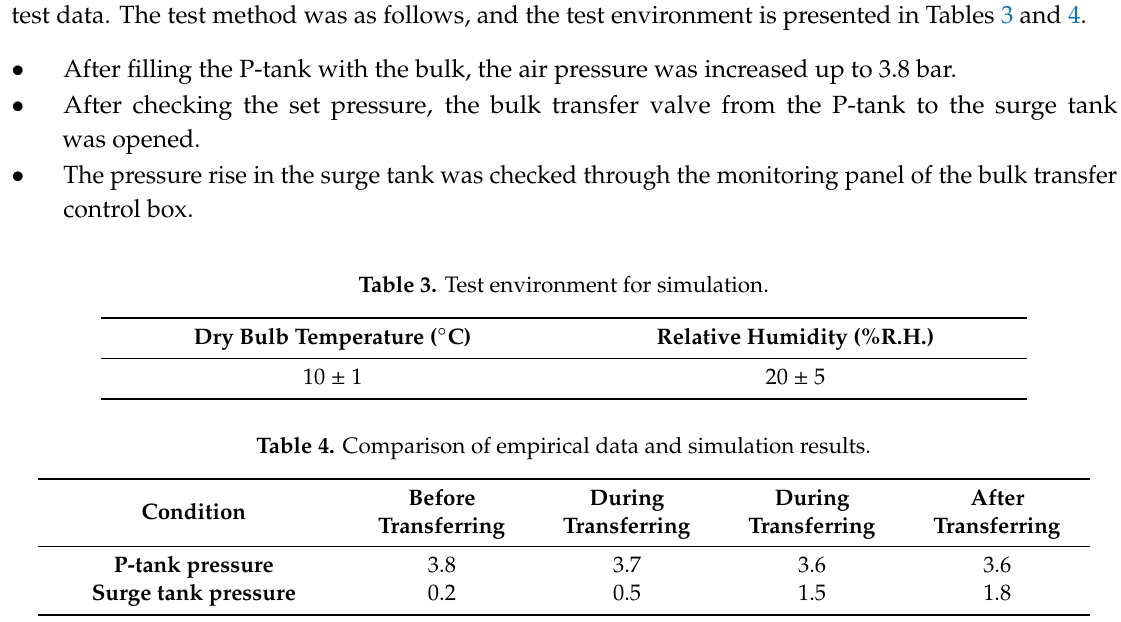
Table 3. Test environment for simulation